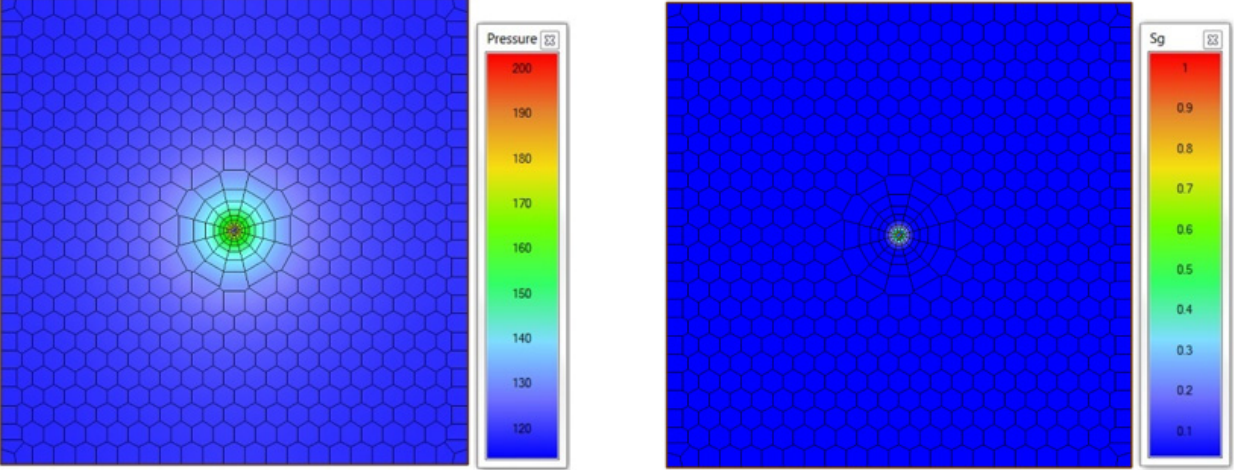
Figure 2. Pressure ( left ) and CO 2 saturation ( right ) distributions in 2D numerical simulations in Saphir.